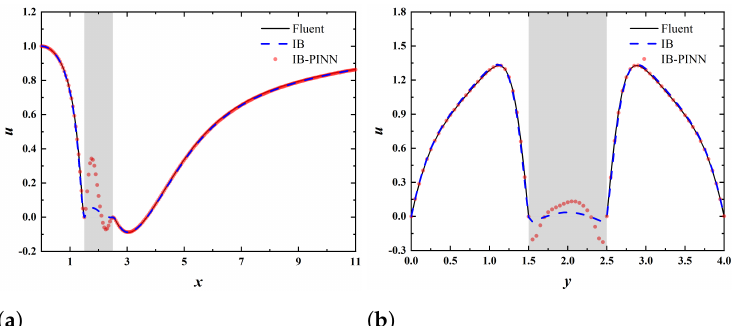
Figure 7. A comparison between the velocity profiles obtained using Fluent, mesh-based IB and IB-PINN. ( a ) streamwise velocity profile along the horizontal centerline; ( b ) streamwise velocity profile along the vertical line passing through the center of the cylinder. The gray rectangles denote the segment inside the